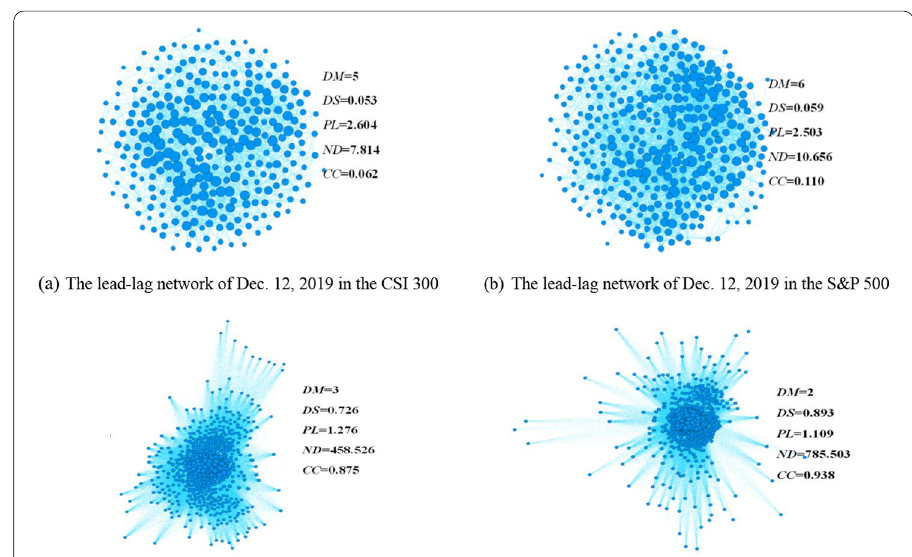
Fig. 5 The lead–lag networks achieved in the two selected stock sets (Δ